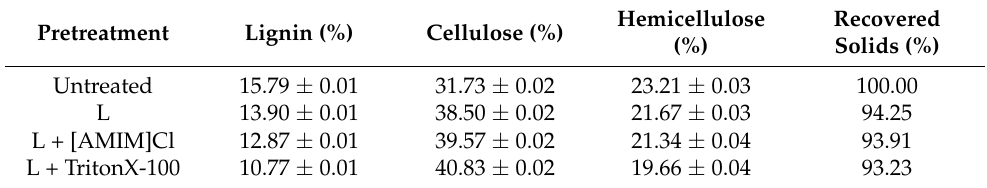
Table 1. Chemical composition of untreated and pretreated rice straw in dry